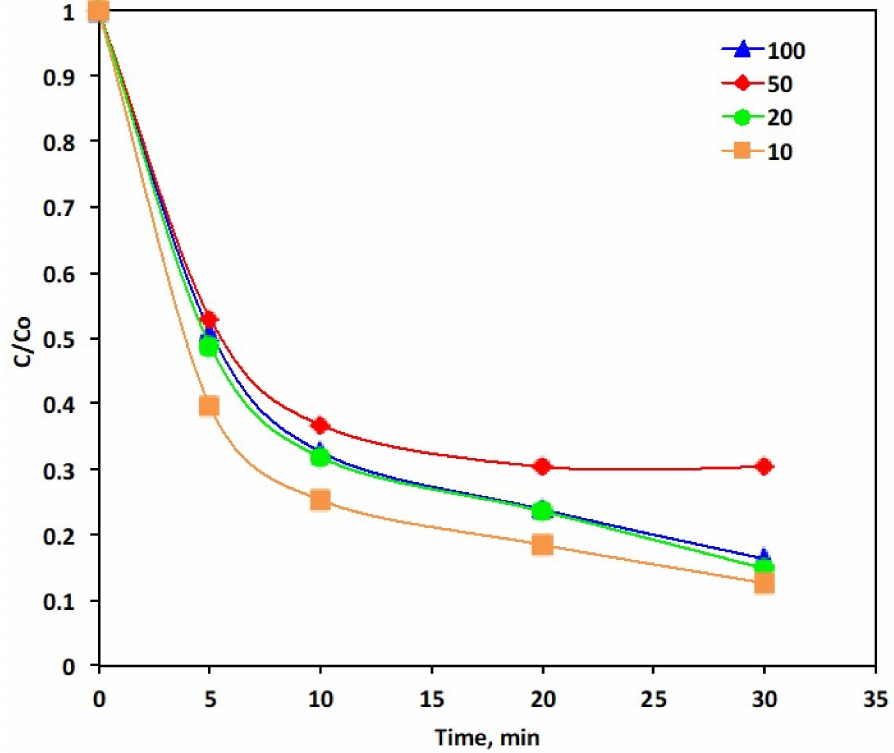
Figure 7. Effect of the PANI-MWCNTs concentration of the Reactive Blue 4 oxidation (Experimental conditions: Reactive Blue 4: 10 ppm; PANI-MWCNTs: